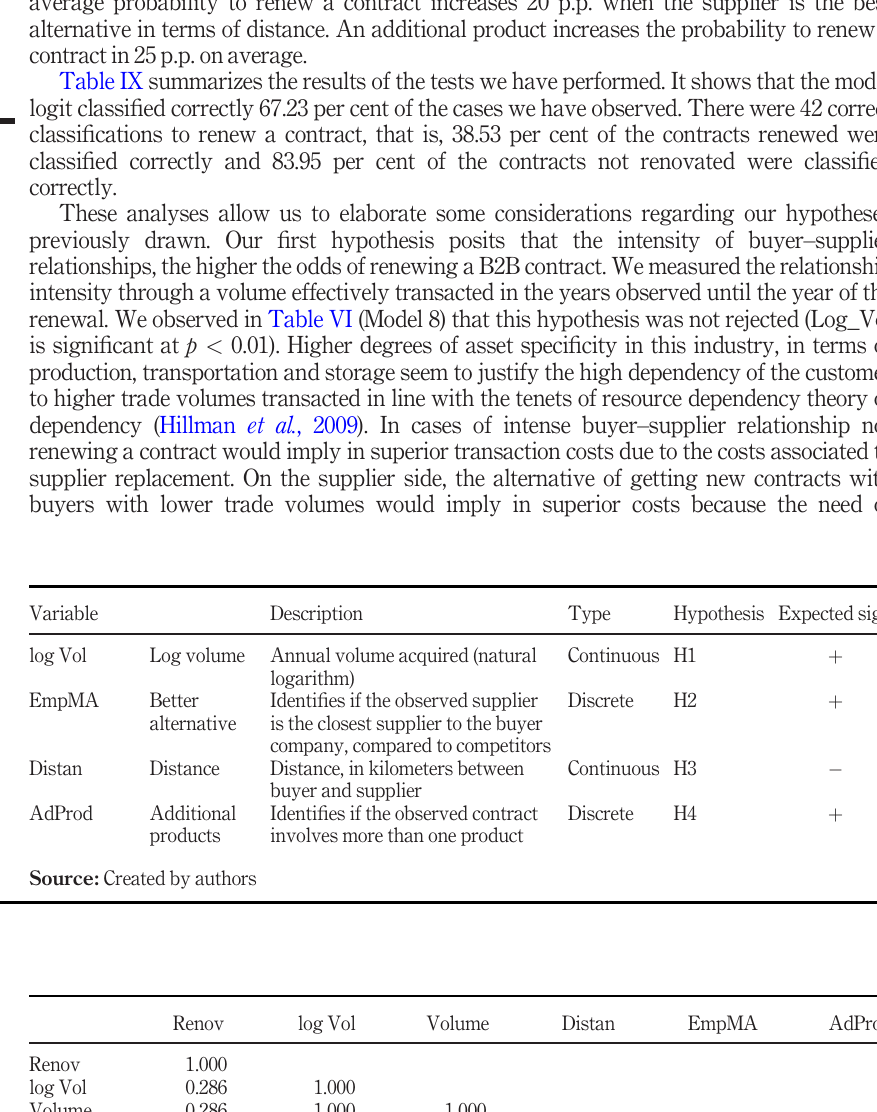
Table V. Spearman correlation matrix